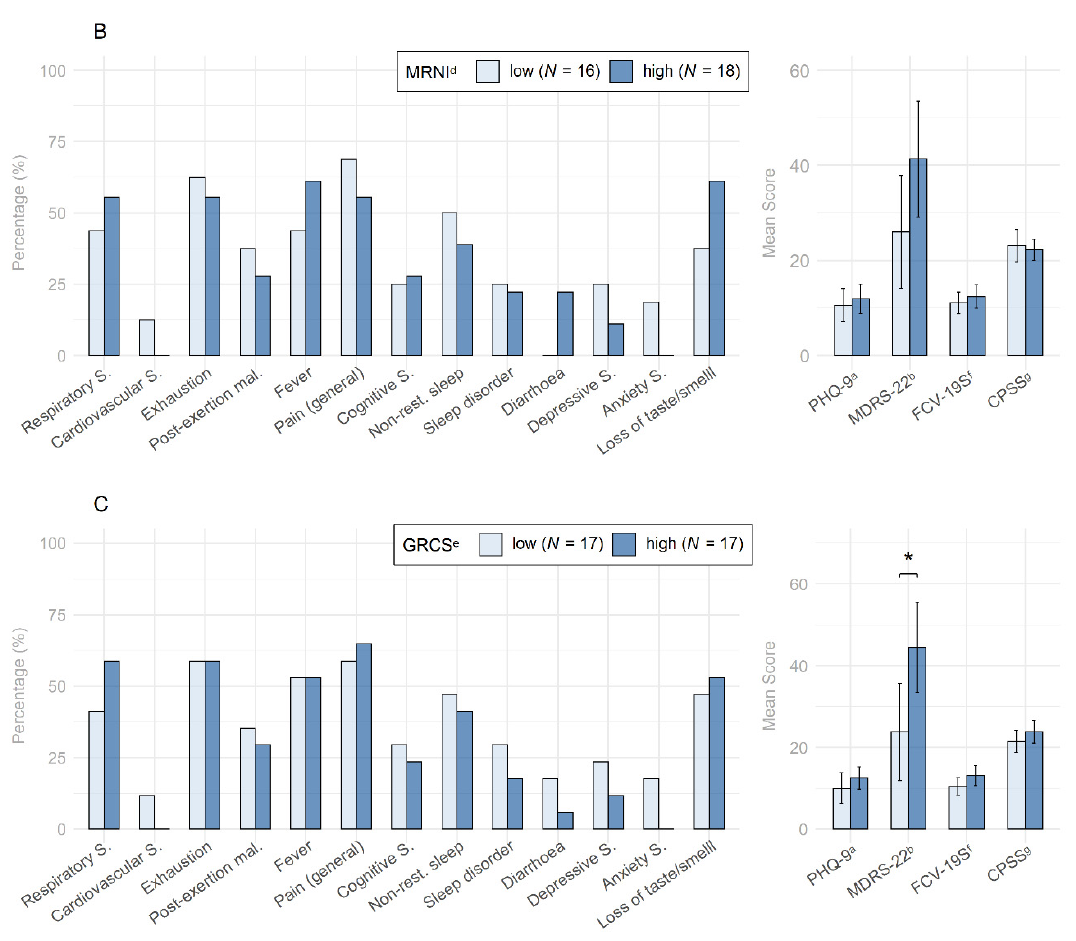
Figure 4. ( A – C ) depict differences in COVID-19 and depression symptoms, fear of COVID-19, and COVID-19 pandemic-related stress between men with low and high traditional masculinity. ( A ) compares the frequency of reported symptoms by high versus low masculine role orientation. ( B ) compares the frequency of reported symptoms by high versus low endorsement of traditional masculinity ideologies. ( C ) compares the frequency of reported symptoms by high versus low gender role conflict. Note: S. = symptoms, mal. = malaise, low/high = below/above the median. a PHQ-9 = Patient health Questionnaire-9; b MDRS-22 = Male Depression Risk Scale-22; (masculinity subscale); d MRNI = Male Role Norms Inventory; e GRCS = Gender Role Conflict Scale; f FCV-19S = Fear of COVID-19 Scale; g CPSS = COVID-19 Pandemic Stress Scale. * = p < 0.05.